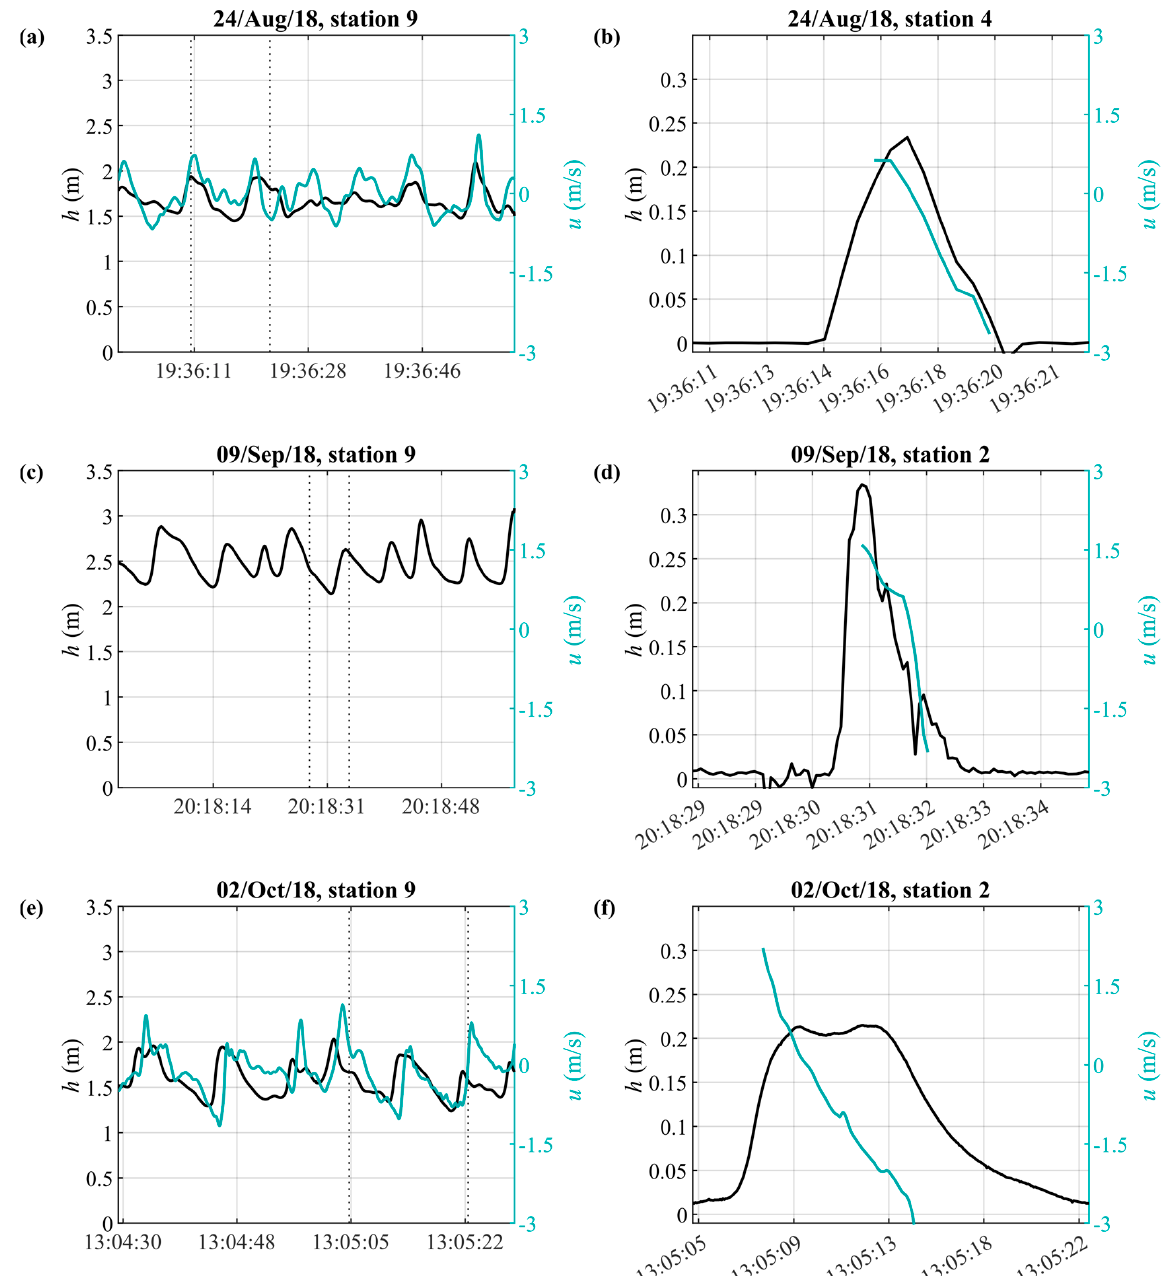
Figure 13. Example hydrodynamics, water depths and near-bed cross-shore velocities observed during the experiment in calm conditions ( a , b ), storm event ( c , d ) and during the period the force balance analysis was carried out ( e , f ).